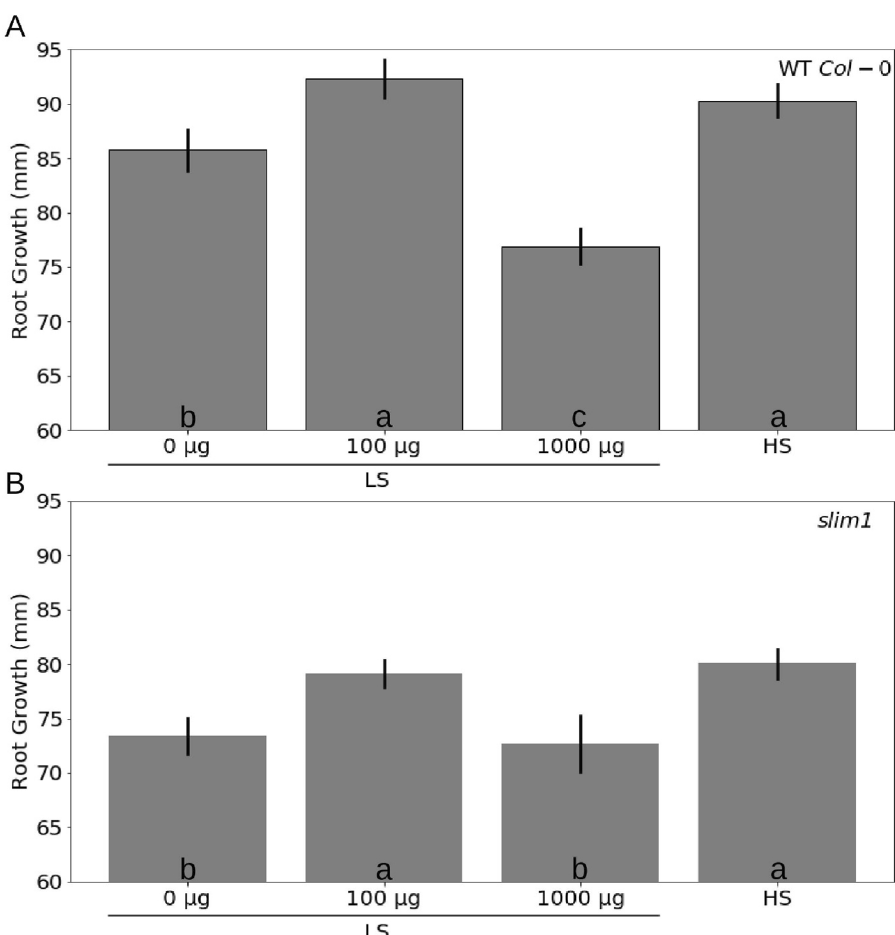
Figure 4. TMTM contributes positively to root growth. Wild-type ( A ) or slim1 ( B ) seedlings’ root growth on high sulfate medium (HS) or on low sulfate medium (LS) with addition of 0, 100 or 1000 µg TMTM was measured 7 days after application. Error bars represent SEs from at least 6 biological replicates for wild-type and 8 biological replicates for slim1 . Statistical significance was determined by Duncan’s multiple range test with p-value < 0.05, and indicated with lower-case